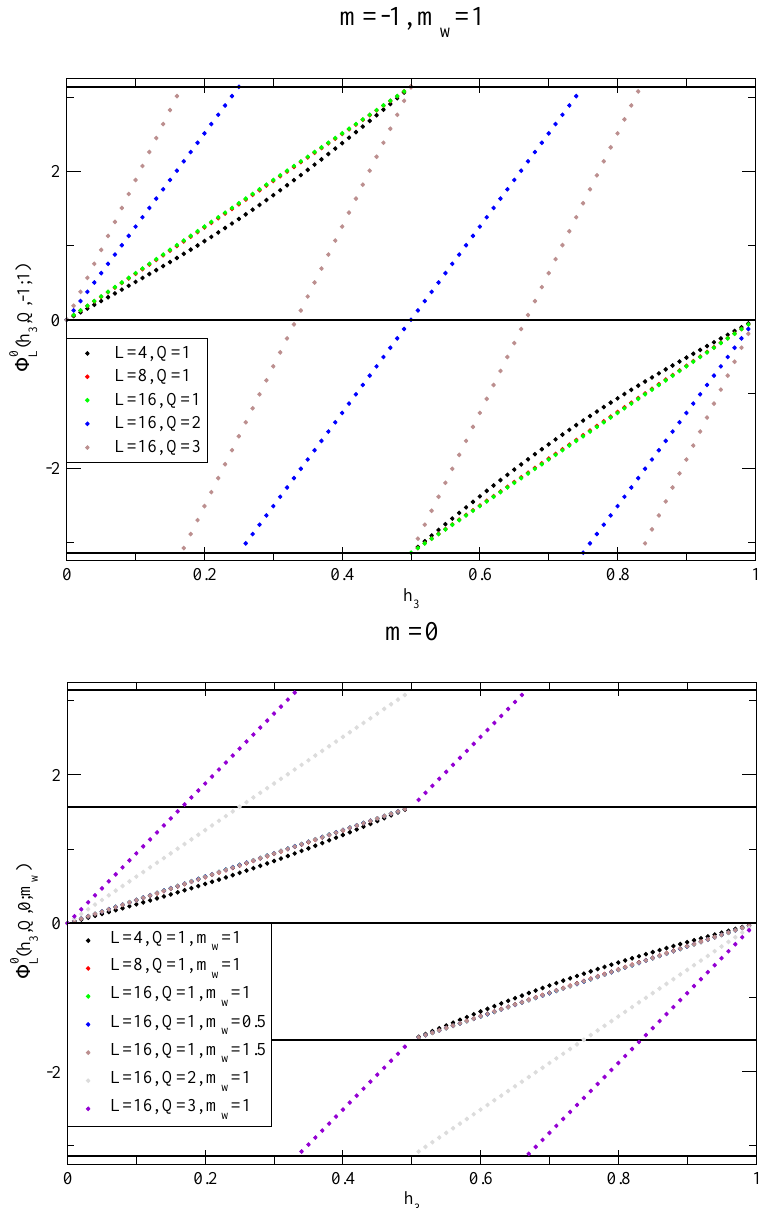
( Q , h 3 ) in the infinite mass case, m = Figure 1. The top panel shows the flow of the phase Φ 0 1, as L − [ 0,1 ] at Q = 1,2,3. The Wilson mass entering the kernel of a function of Wilson-loop variable h 3 ∈ overlap operator is fixed at m w = 1. For fixed Q = 1, the variation with reduction in lattice spacing by increasing L from 4 to 8 is also shown. The bottom panel shows similar flow of the phase of the determinant in the massless case. The variability with respect to the regulator parameter m w and lattice spacing are